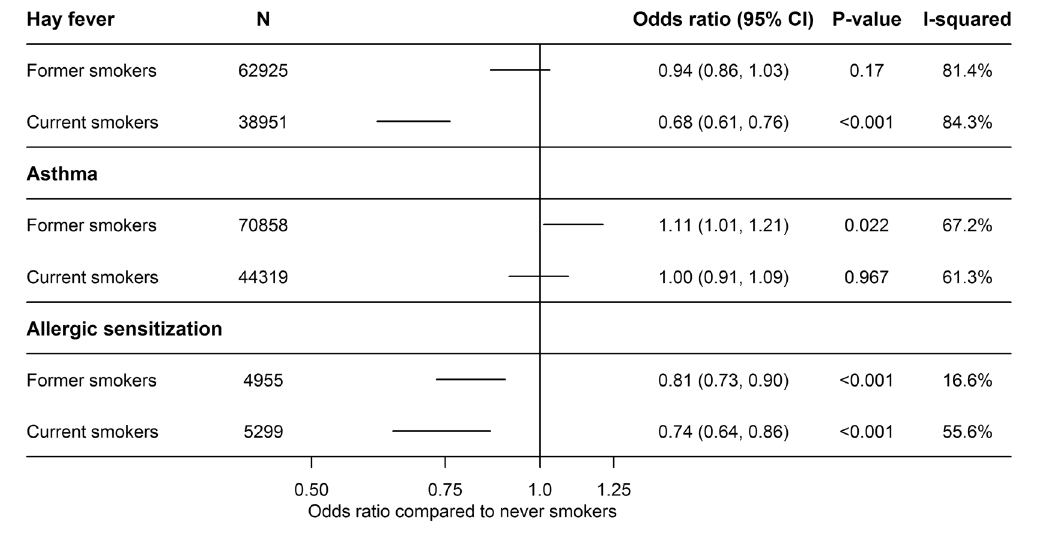
Figure 1. Age- and sex-adjusted associations of smoking status with hay fever, asthma and allergic sensitization using random effect meta-analysis.